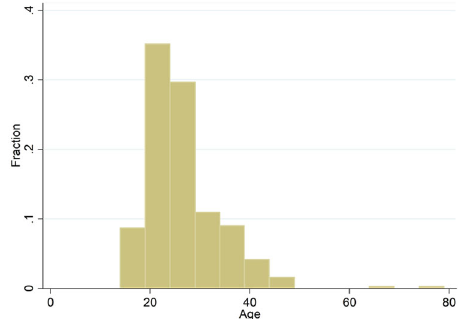
Fig. 1 Distribution of age among respondents. Respondents distribution by age (year).